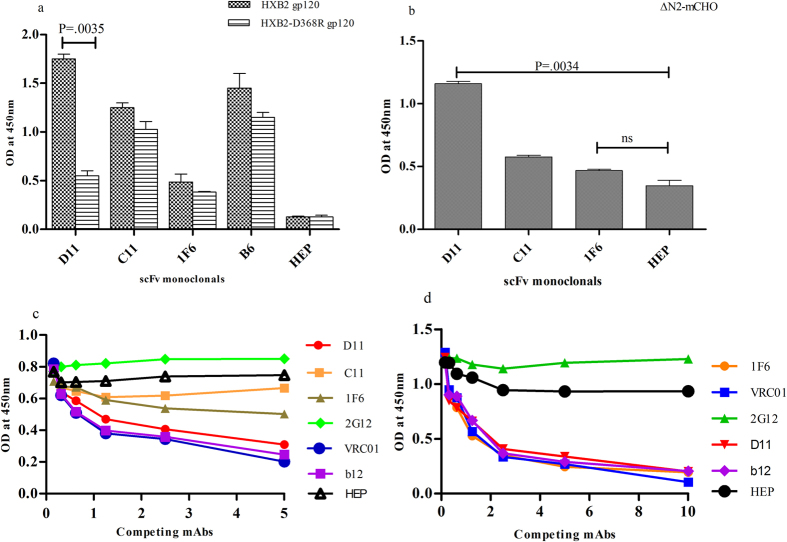
ELISA to determine the epitope specificities of scFv monoclonals.(a) Purified scFv monoclonals (at 10 μg/ml concentration) were further checked for binding reactivity with HXB2 gp120 and its D368R mutant by ELISA (b) and also their binding with ∆N2-mCHO (at 10 μg/ml concentration) to determine CD4bs specificity. HEP scFv, the scFv against the hepatitis antigen served as negative control for all the assays. Mean binding titres were compared using un-paired t test. P values < 0.05 were considered significant. (c) Competition ELISA of biotinylated b12 (at fixed concentration of 50 ng/ml) to RSC3 with decreasing concentrations of scFvs (D11, C11, 1F6 and HEP) and mAbs (2G12, VRC01, b12). 2G12 and HEP scFv were used as negative controls and the bnAb VRC01 was used as positive control for the assay. Dilution used for antibodies is 5 μg/ml to 0.1526 μg/ml. (d) Competition ELISA of biotinylated VRC01 (at fixed concentration of 100 ng/ml) to BG505:SOSIP.664 with decreasing concentrations of scFv monoclonals (D11, 1F6 and HEP) and mAbs (2G12, VRC01, b12). The mAb 2G12 and HEP scFv were negative controls and mAb b12 was the positive control in the assay. Dilution used for antibodies is 10 μg/ml to 0.3125 μg/ml.